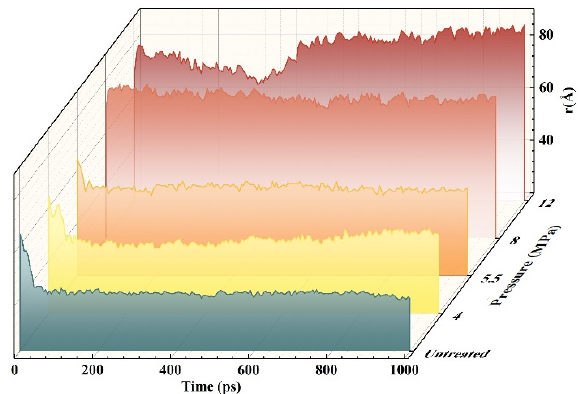
Figure 5. End distance distribution curve of cellulose chain.